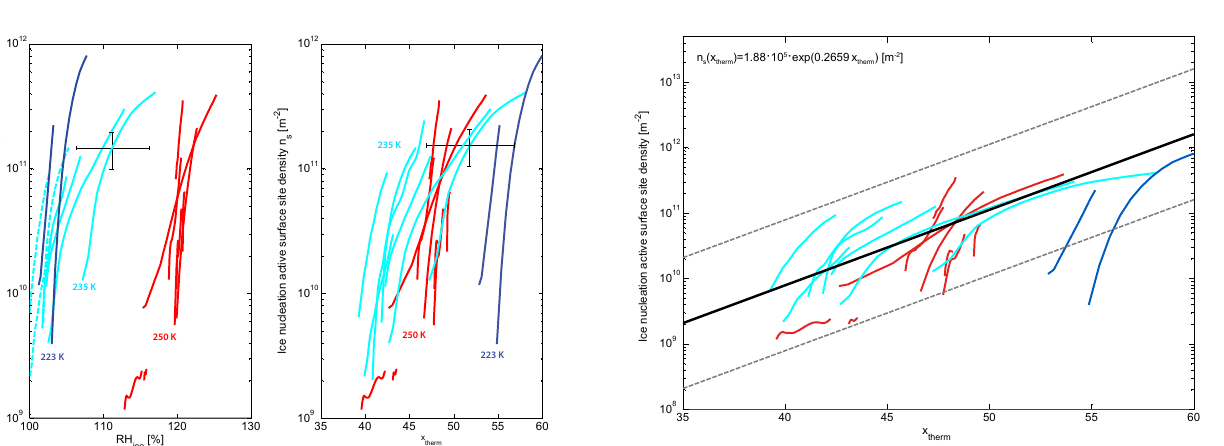
ice nucleation thresholds in this study. These ice nucleation thresholds are depicted in Fig. 4 for all experiments. For the experiments starting at 250 K, the ice nucleation thresholds scatter around RH ice ≈ 120%. Note that for two experiments the ice fraction remained below f ice = 1%. The humidity